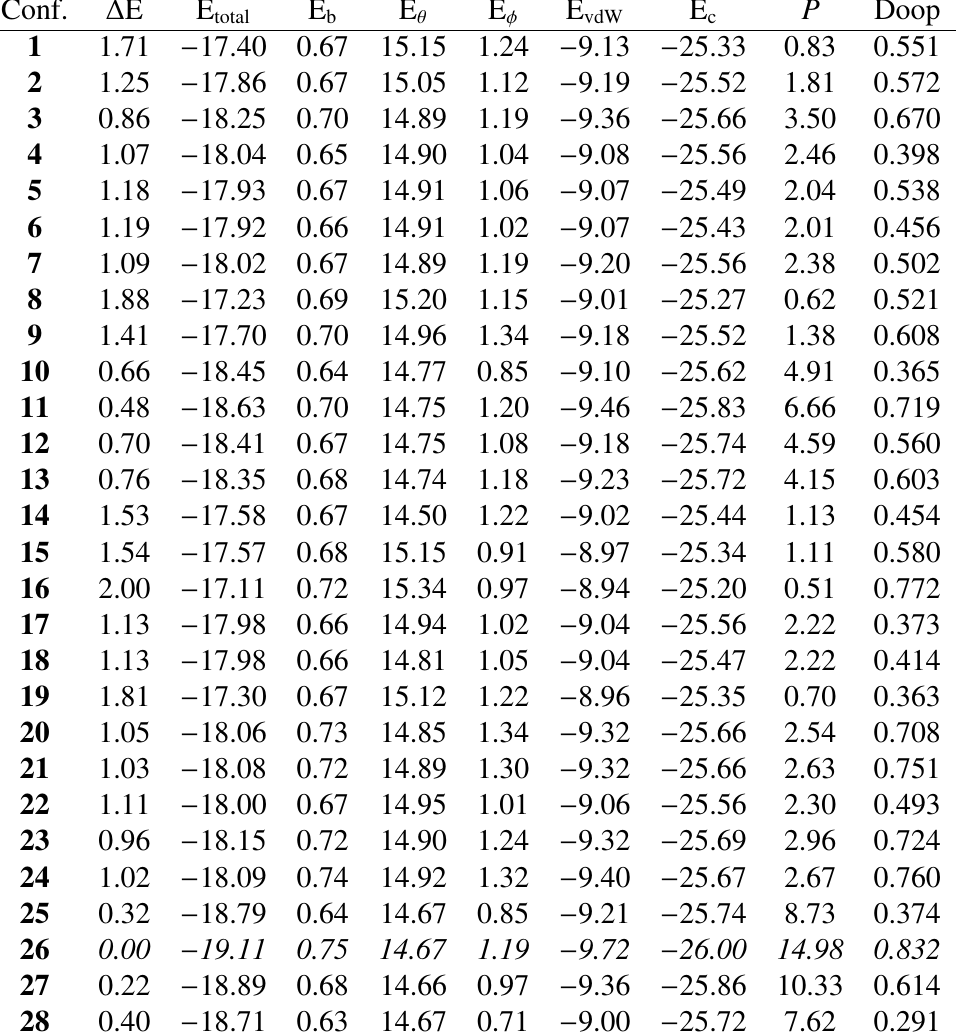
Table 1. Relative minimum energies ∆ E and energy contributions (in kcal / mol) from bond stretching (E ), angle bending (E ), torsional (E ), van der Waals (E ), and Coulomb (E ) interactions for the 28 b θ φ vdW c isolated Ni(OEP) conformers, calculated Boltzmann population ( P ) at 298K, and out-of-plane (Doop) distortion of the porphyrin core (in Å). Data for the global minimum (conformer 26 ) are italicized.